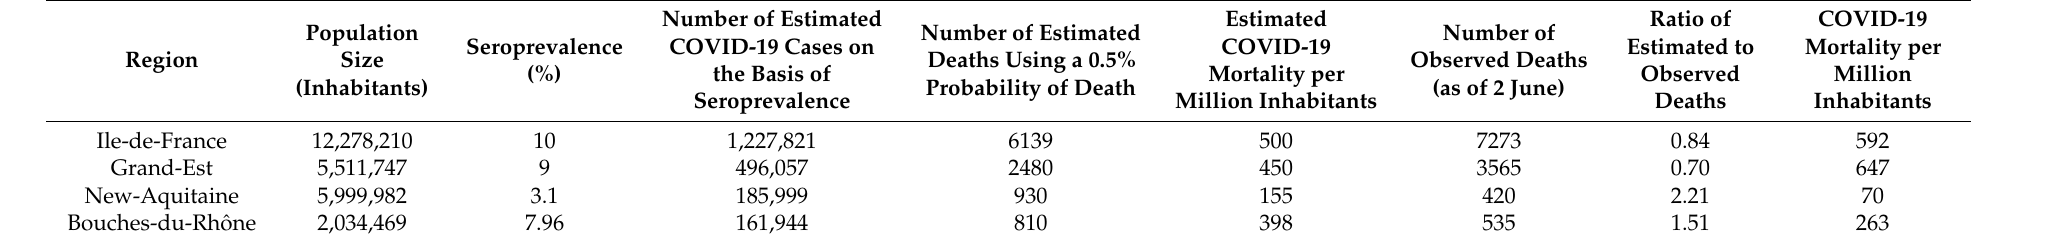
Table 3. Mortality estimation according to the prevalence of antibodies after a delay.